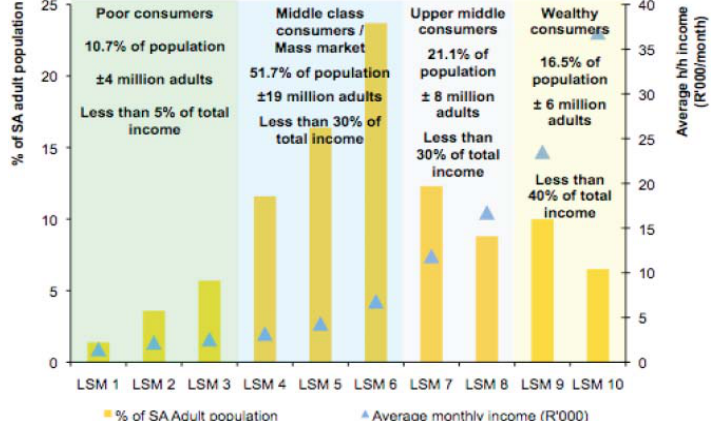
Fig. 2. The SAARF LSM segments: proportion of SA adult population and average monthly household income 2013 Source: BFAP (2014, p.